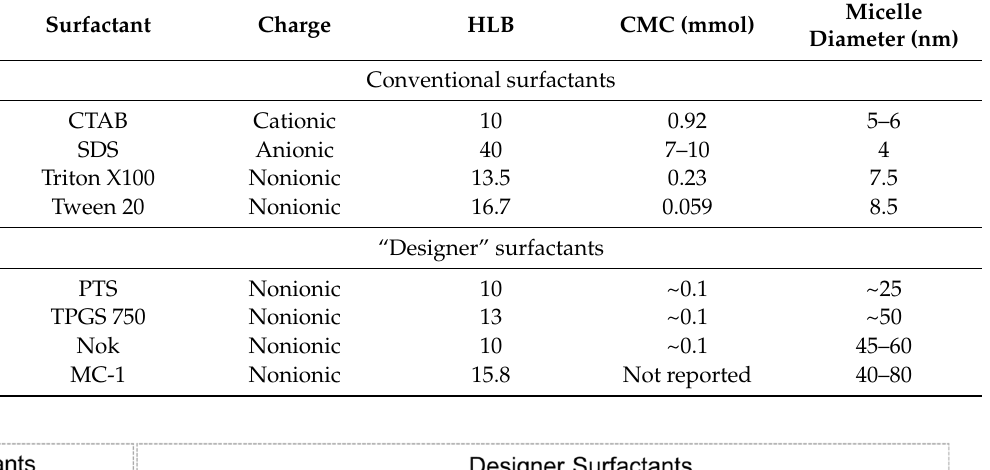
Table 2. Comparison of properties and micelle sizes of conventional surfactants and surfactants designed specifically for catalytic applications in water [55,56,58–61].